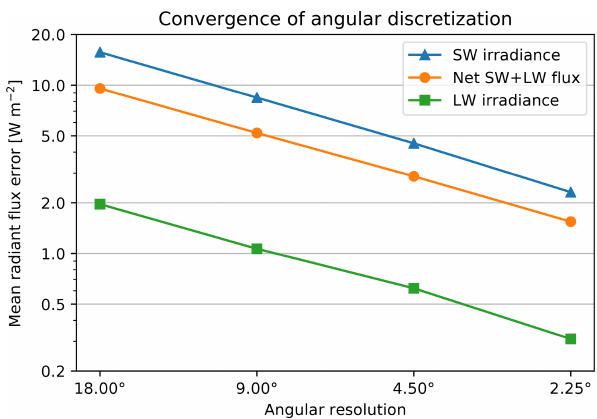
Figure 7. Double-logarithmic presentation of mean deviations of surface SW and LW irradiance as well as net radiant flux for differ- ent angular resolutions. Mean deviations are shown relative to the finest angular resolution of 1.125 ◦